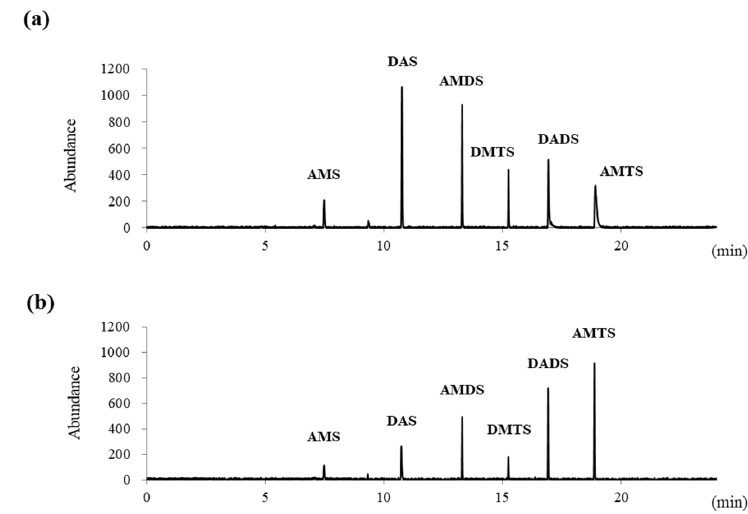
Figure 2. PFPD chart of deodorant activity of BCO against 15 µ g of GEO at pH 1.2: ( a ) without BCO, ( b ) 10 mg of BCO added to GEO for 180 min.